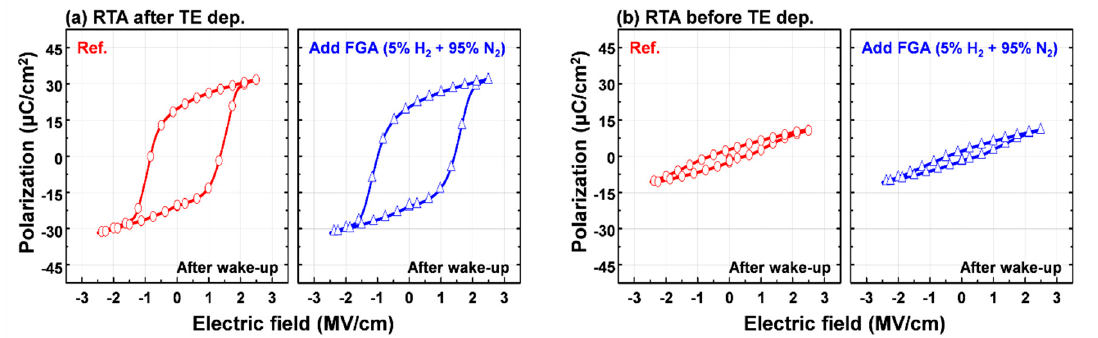
Figure 6. The polarization-electric field hysteresis curves of 10-nm-thick HZO-based MIM capacitors with and without additional FGA processes: HZO films annealed at 400 °C ( a ) after TiN top electrode deposition and ( b ) before TiN top electrode deposition.